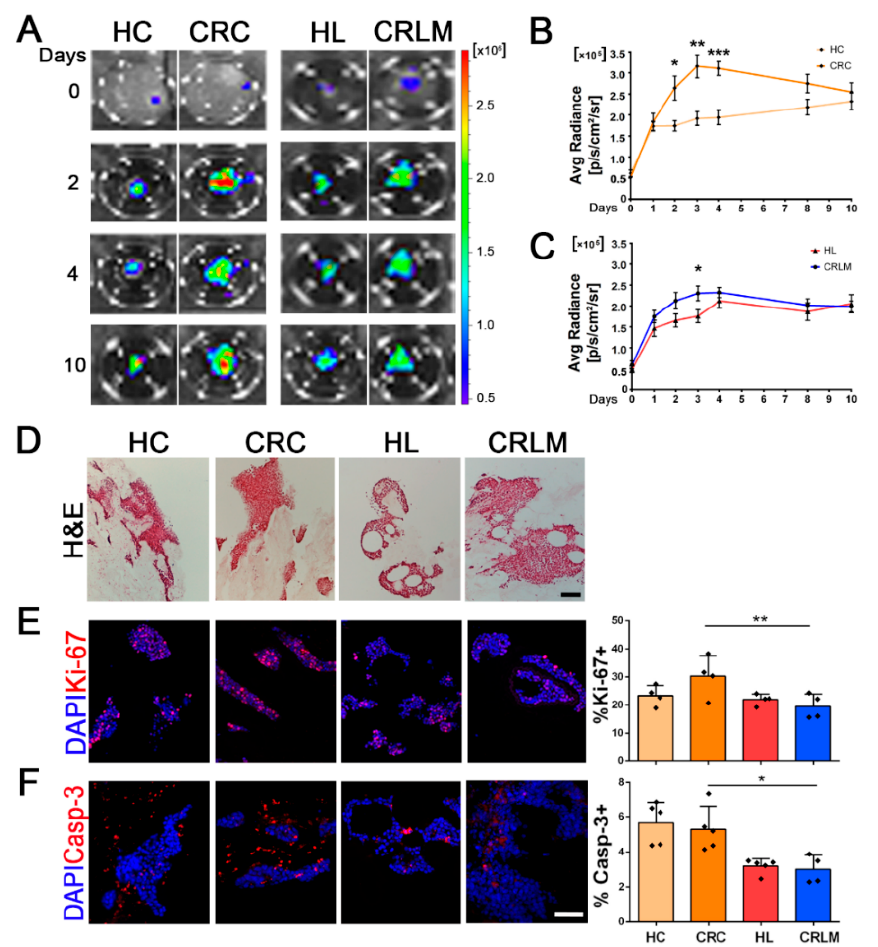
Figure 2. Characterization of recellularized CRC and CRLM scaffolds using IVIS and immunofluorescence. ( A ) Representative bioluminescence pictures show the proliferation rate of HT-29 ZsGreen/Luc + cells seeded in healthy (healthy colon (HC) and HL) and neoplastic decellularized scaffolds (colorectal cancer (CRC) and CRLM) from day 0 to day 10. ( B ) Line graphs summarize the proliferation rate of HT-29-recellularized CRC vs. HC (HC, n = 4; CRC, n = 4) and ( C ) CRLM vs. HL (HL, n = 4; CRLM, n = 5). ( D ) Representative H&E images of 3D patient-derived scaffolds 10 days after recellularization with HT-29 cells. Immunofluorescent images and quantifications at day 10 of ( E ) Ki-67 + and ( F ) activated Caspase-3 + ; nuclei were counterstained with DAPI (blue). Scale bar: 50 µm. For line graphs, * p -value < 0.05; ** p -value < 0.01; and *** p -value < 0.001 by Student’s t -test. For graph bars, * p -value < 0.05 and ** p -value < 0.01 by a one-way ANOVA test following Tukey's Multiple Comparison Test.